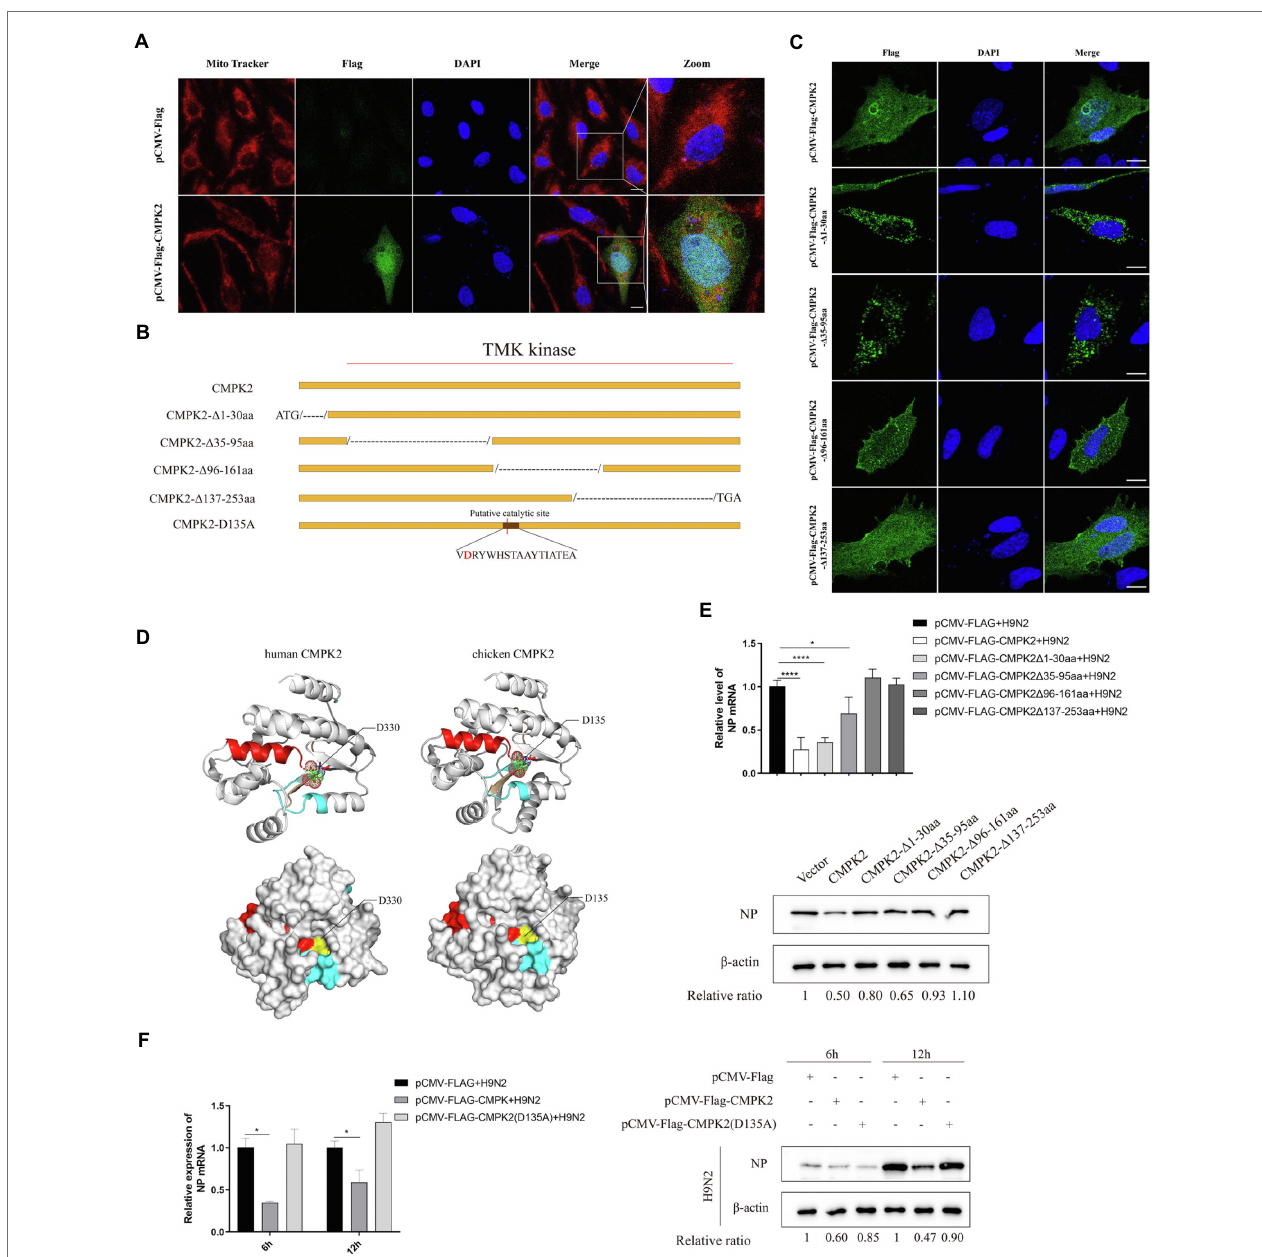
FIGURE 8 | The role of the TMK domain in the antiviral effect of chCMPK2. (A) Subcellular localization of CMPK2 in DF-1 cells. DF-1 cells were transfected with pCMV-Flag control and pCMV-Flag-CMPK2. At 24 h post-transfection, mitochondria were stained with Mito Tracker Red for 30 min, cell nuclei were stained with DAPI, and samples were observed by confocal laser scanning microscopy. (B) The chCMPK2 was truncated into four parts (CMPK2- Δ 1-30aa: amino acids 1–30 were truncated; CMPK2- Δ 35-95aa: amino acids 35–95 were truncated; CMPK2- Δ 96-161aa: amino acids 96–161 were truncated; CMPK2- Δ 137-253aa: amino acids 137–253 were truncated) and the mutant plasmid chCMPK2(D135A) was designed to investigate the key fragments in antiviral function. (C) DF-1 cells were transfected with CMPK2- Structure Database. The chicken CMPK2 protein structure was predicted by using huCMPK2 as a template. The P-loop, the putative catalytic site, and the lid motif are shown in yellow, red, and blue, respectively. D330 of huCMPK2 and D135 of chCMPK2 are labeled in the structures. (E) DF-1 cells were transfected with four truncated plasmids, pCMV-Flag-CMPK2 (positive control), and pCMV-Flag (negative control) for 24 h, and then cells were infected with H9N2 at an MOI of 0.1. At 6 hpi, the cells were collected to detect the expression of NP by qRT-PCR (up) and WB (down) assays. The gray intensity for each band was measured, and the relative ratio of AIV NP was determined from the equation (Sample NP /Sample actin )/(Mock NP /Mock actin ) and marked at the bottom of each lane. (F) DF-1 cells were transfected with pCMV-Flag-CMPK2, pCMV-Flag, and CMPK2(D135A) and then infected with H9N2 at an MOI of 0.1. The expression of NP was measured by qRT- PCR (up) and WB (down). Values represent the mean of the individual measurements in each sample ± SEM. * p < 0.05 and **** p <